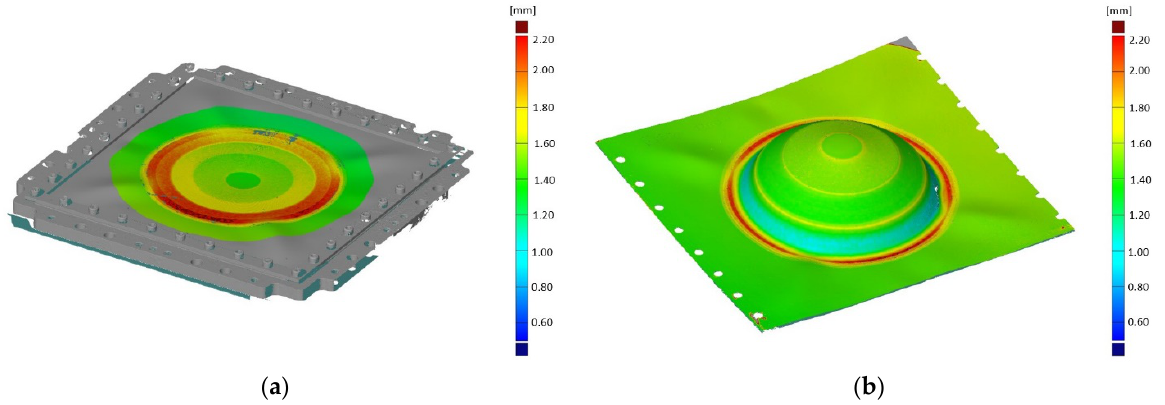
Figure 20. Three-dimensional scans of the LMD tailored SPIF preform and part: ( a ) Thickness distribution across LMD tailored SPIF preform; ( b ) Thickness distribution across LMD tailored SPIF part.